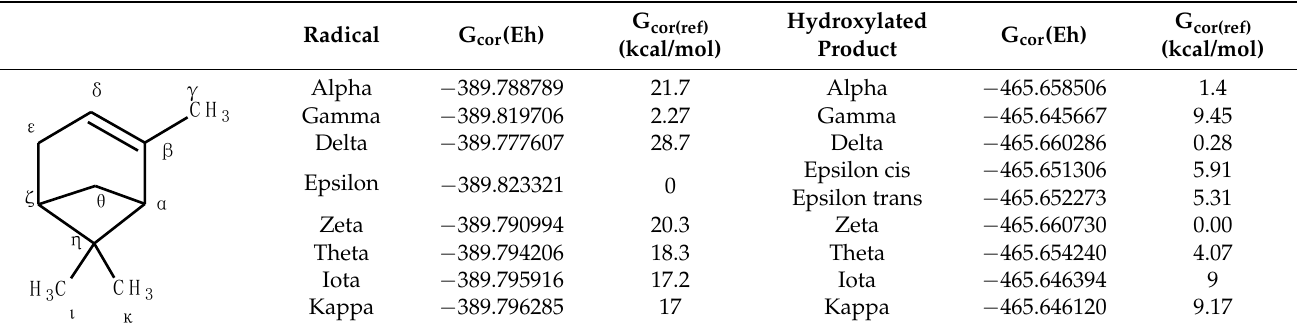
Table 1. Computed relative energies of the radicals and hydroxylated products of α -pinene. The term “cor” refers to the dispersion, BSSE, and Grimme quasi-harmonic corrections to the calculated absolute Gibbs free energies (in Hartree). Energies in kcal/mol were calculated with reference to the most stable conformation for the hydroxylated radical and product. G cor(ref) Radical G cor (Eh) (kcal/mol) Product